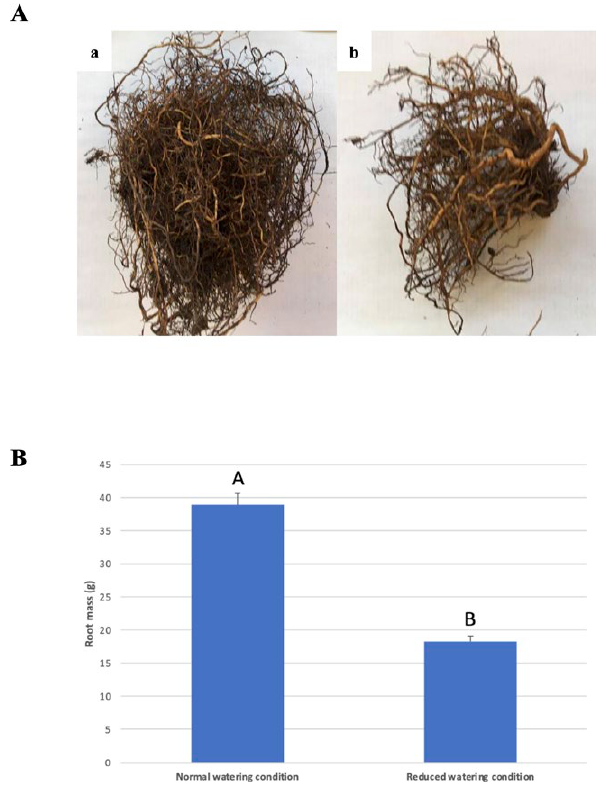
Figure 2. A. Mean (± SE; of 54 plants) root weights for potted grapevines in an open greenhouse. a) control plant roots. b) plant roots under water deficit. B. Mean root weights for potted grape- vines in an open greenhouse. Different letters indicate differences ( P = 0.05; Newman and Keuls’ test after